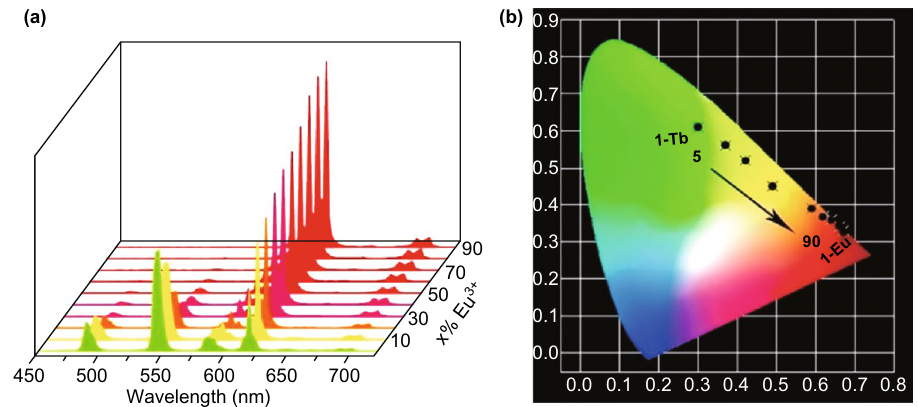
Fig. 21 a Solid-state emission spectra of {[Eu x Tb 1− x (L)(H 2 O) 2 ]·5H 2 O} n with different molar ratios of Eu 3+ under excitation of 302 nm. b CIE chromaticity diagram of {[Eu x Tb